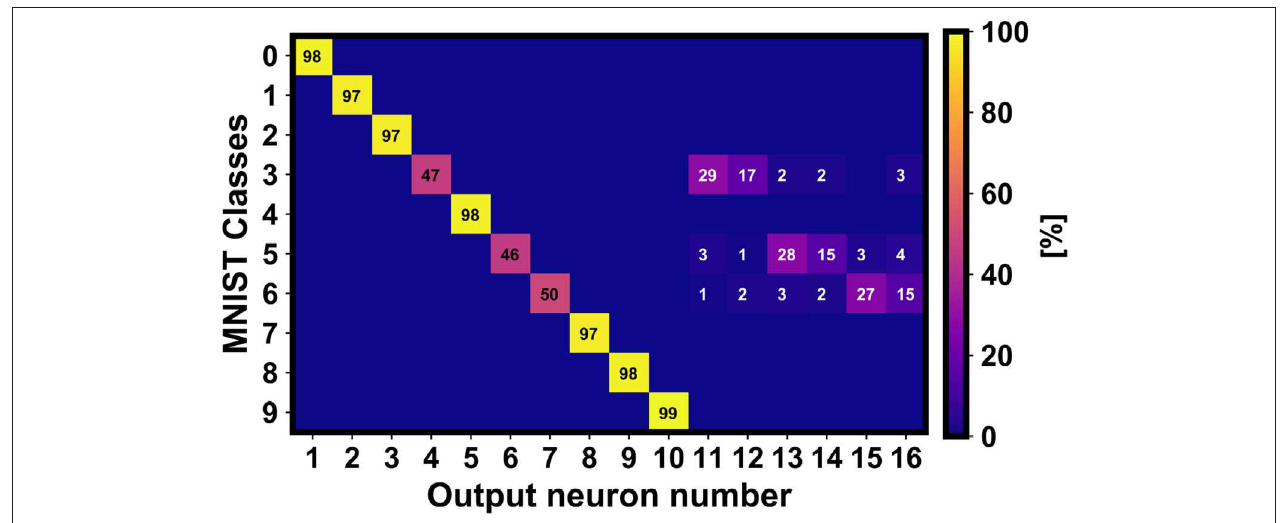
FIGURE 9 | Confusion matrix related to the classification results of the non-trained classes 3, 5, and 6 including the neural redundancy of 3 output neurons per non-trained class. As observed, the additional output neurons improve significantly the global accuracy.